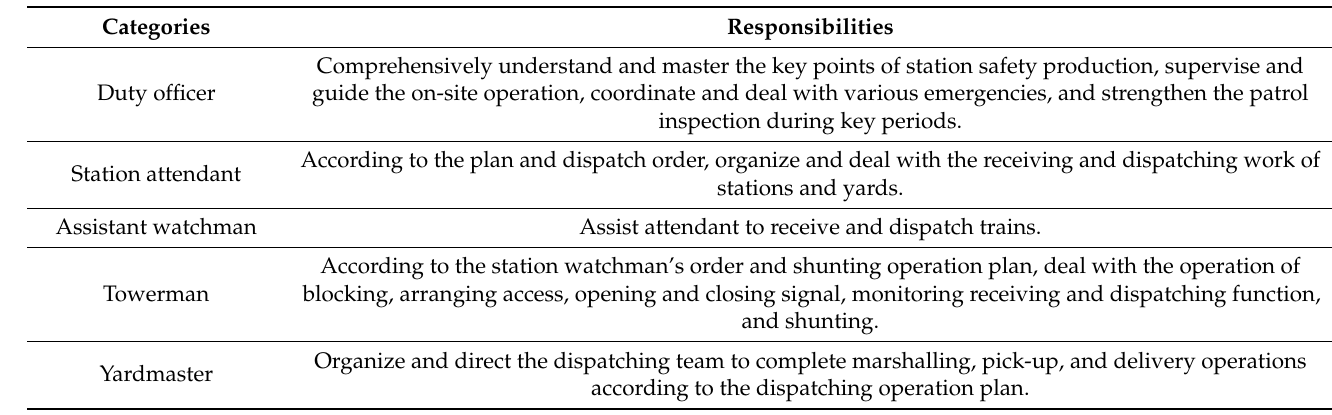
Figure 4. Code structure of grid elements in the train operation department.